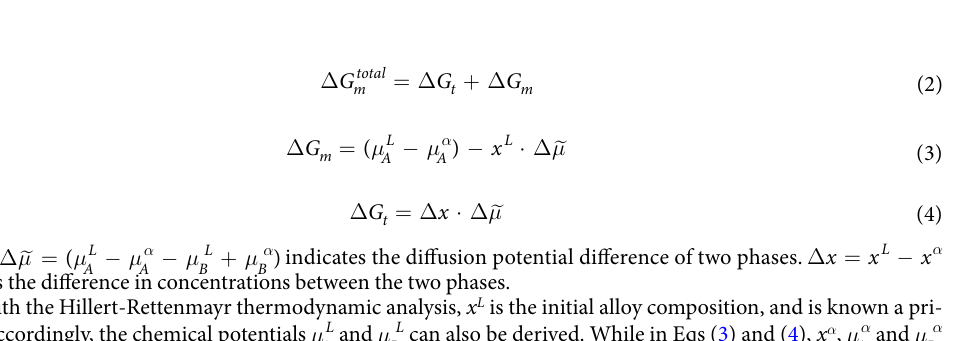
indicates the diffusion potential difference of two phases. Δ = − α x x L B